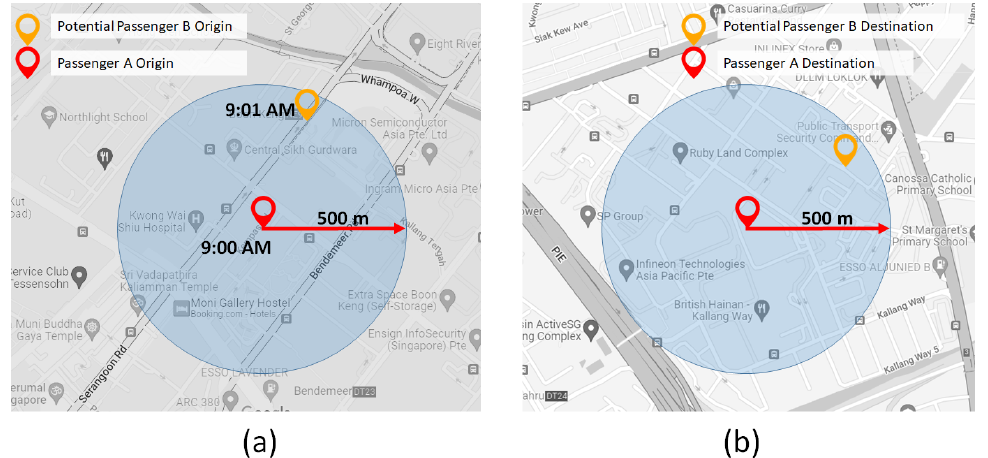
Figure 3. Example Scenarios of Stable Matching ( a ) where a Passenger B’s origin (yellow), discovered at 9:01 a.m. and within the r = 500 m of Passenger A (red) position, discovered at 9:00 a.m. and